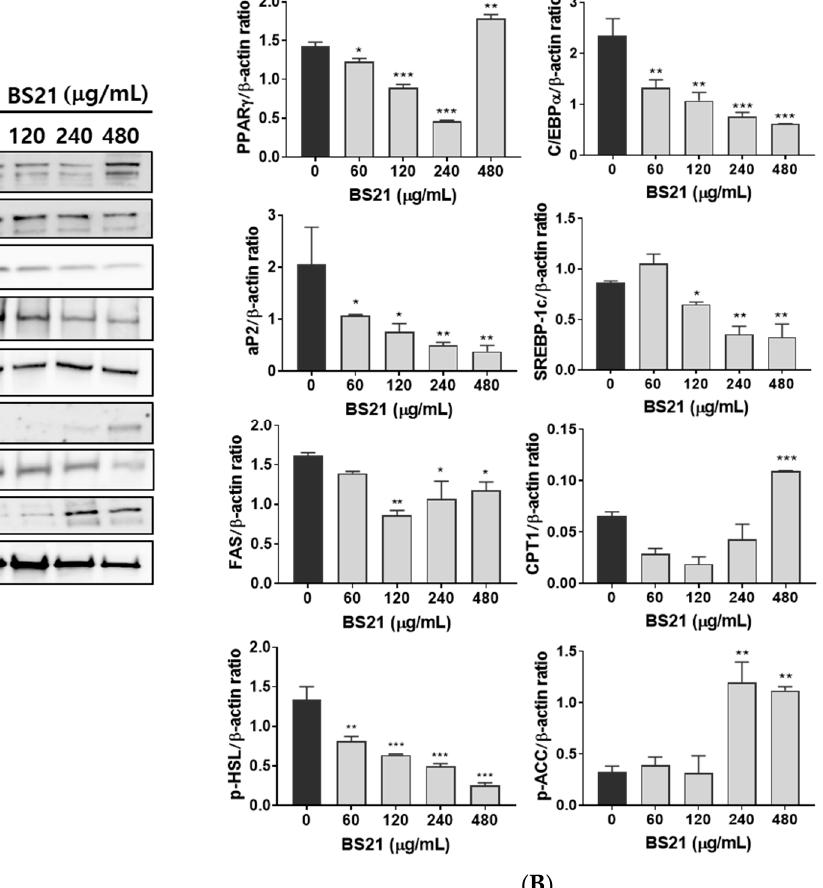
Figure 2. Effect of a 2:1 mixture of Phyllostachys pubescens and Scutellaria baicalensis (BS21) on lipid metabolism-related protein expression in 3T3-L1 cells. ( A ) Representative bands and ( B ) relative changes in protein expression levels. The relative expression levels of proteins were normalized against a β -actin internal control. Values are expressed as means ± SD ( n = 3). Significant differences were observed between differentiated MDI (3-isobutyl-1-methylxanthine, dexamethasone, and insulin) cells and BS21-treated cells: * p < 0.05, ** p < 0.01, and *** p < 0.001.